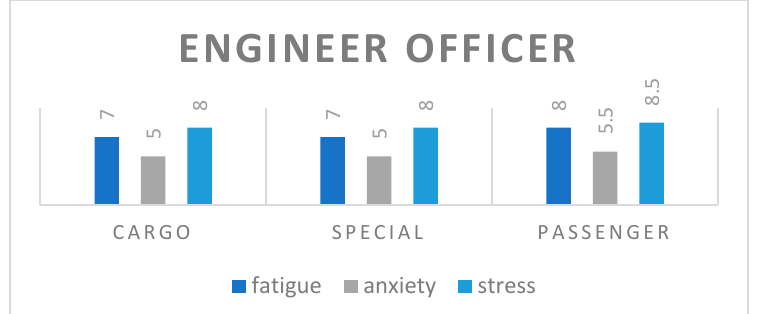
Figure 5. Comparative rates of fatigue, anxiety and stress among engine officers on various types of vessels .